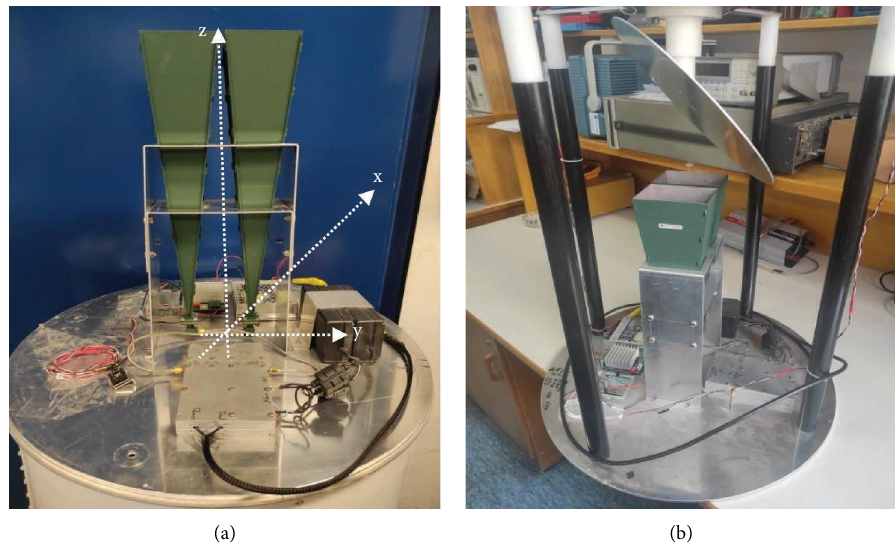
Figure 2: Te proposed 24 GHz CW Doppler radar system: (a) axis orientation-static mode and (b) overview-360 ° scanning mode.